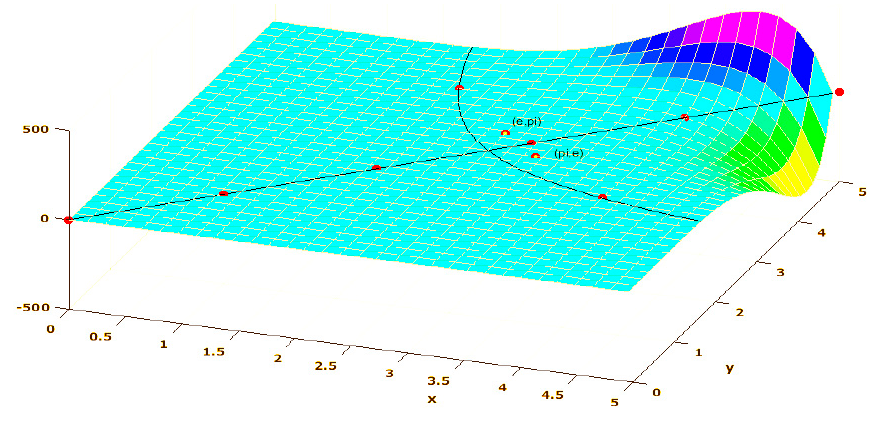
Figure 11. 3D view of the PIV characteristics of the solar PV source. Table 1. Processing time of MPPT and